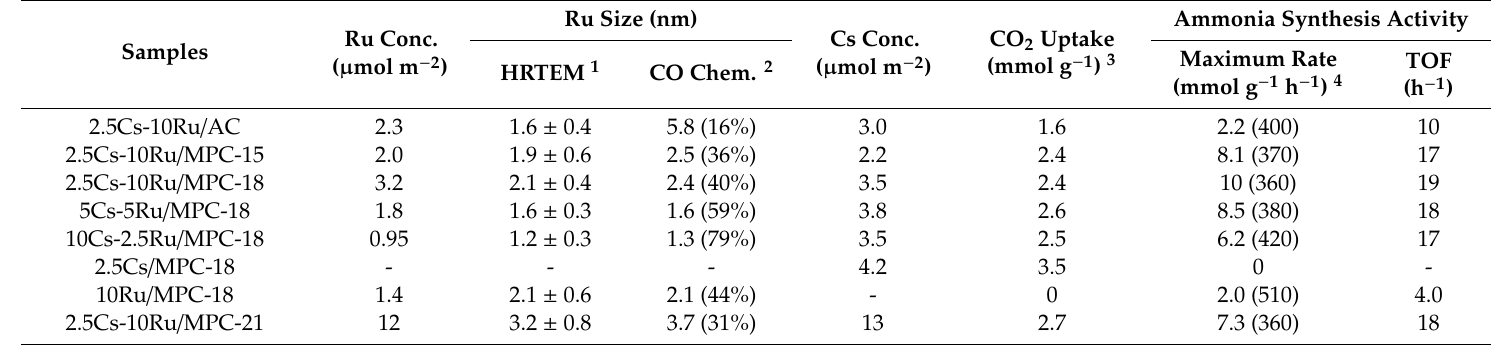
Table 2. HRTEM image and gas chemisorption studied on the Ru and Cs species of the prepared Cs-Ru catalysts and their catalytic performances in ammonia synthesis.